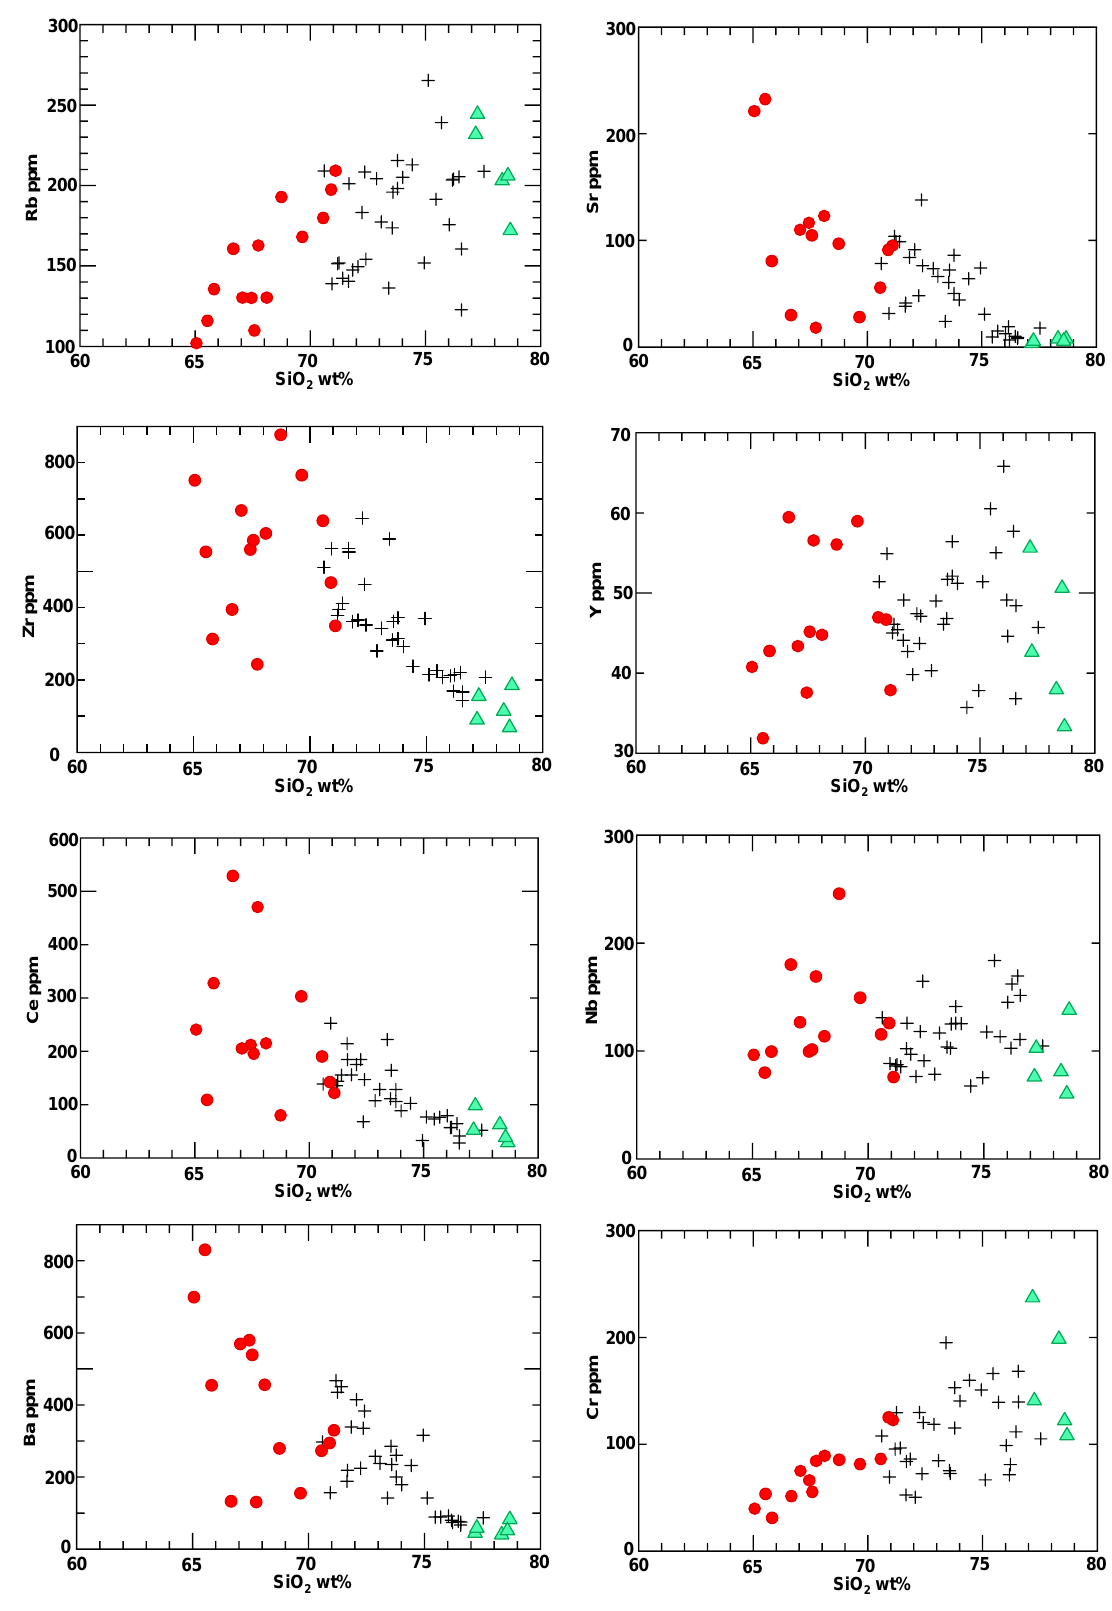
Figure 2. Radioactive element plots for ground gamma ray spectrometry measurements of syenogranite, alkali feldspar granite and quartz syenite at Nikeiba, Southeastern Desert, Egypt. Symbols are the same in the following diagrams ( + syenogranite, alkali feldspar granite and quartz syenite); diagram axes indicate data plots in logarithmic scale. ( a ) eTh (ppm) vs. K %; ( b ) eU (ppm) vs. eTh (ppm); ( c ) eU/eTh ratio vs. eTh (ppm); ( d ) eU/eTh ratio vs. eU (ppm); ( e ) eU-(eTh/3.5) vs. eU (ppm) binary diagrams.